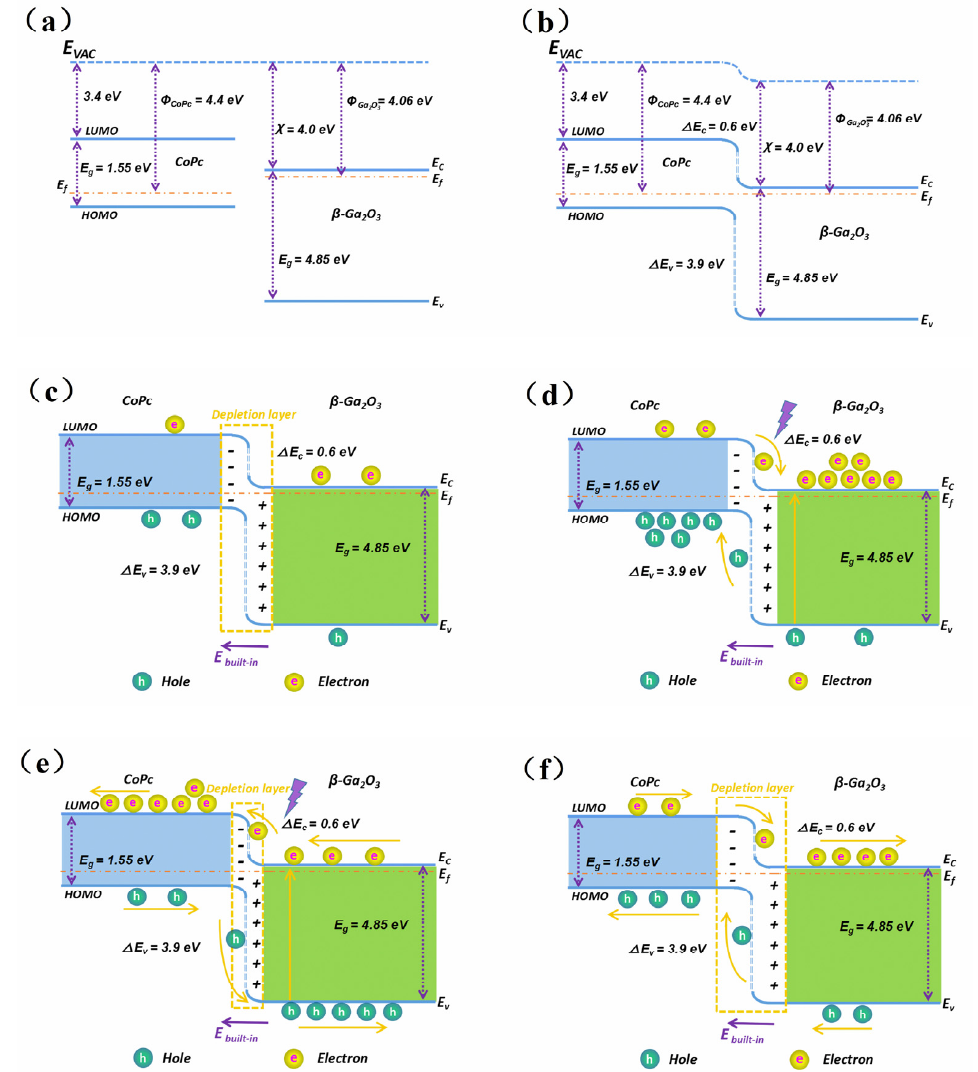
Figure 6. Schematic energy band diagrams of the CoPc/Ga 2 O 3 heterostructure ( a ) before contact, ( b ) after contact, ( c ) under dark conditions, ( d ) with 254 nm light under 0 V, ( e ) with 254 nm light under forward voltages, and ( f ) with 254 nm light under reverse voltages.